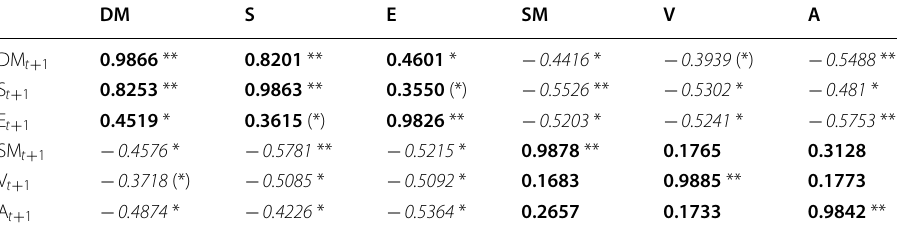
Table 1 This table shows the relationships between NeuroSynth terms scores, calculated using the mean activity brain map for each state and the one step ahead projected score for each term according to the model (see Eq.